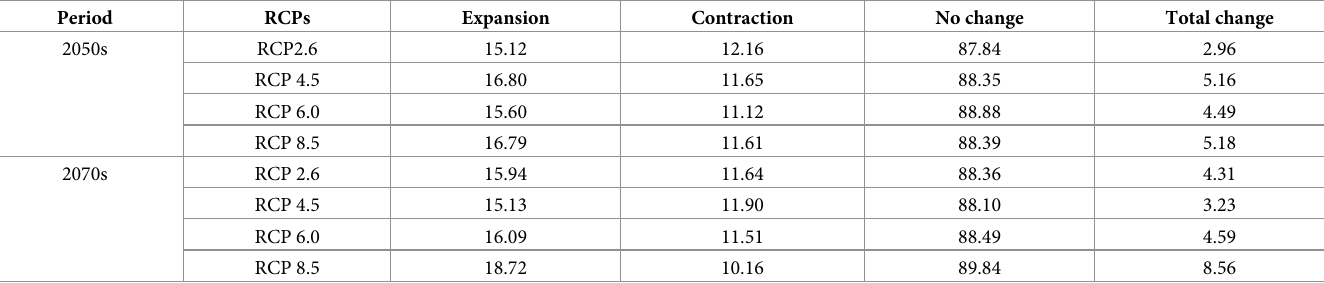
Table 3. Changes of the suitable area of Betula Platyphylla Suk. under different climate scenarios (%). Period